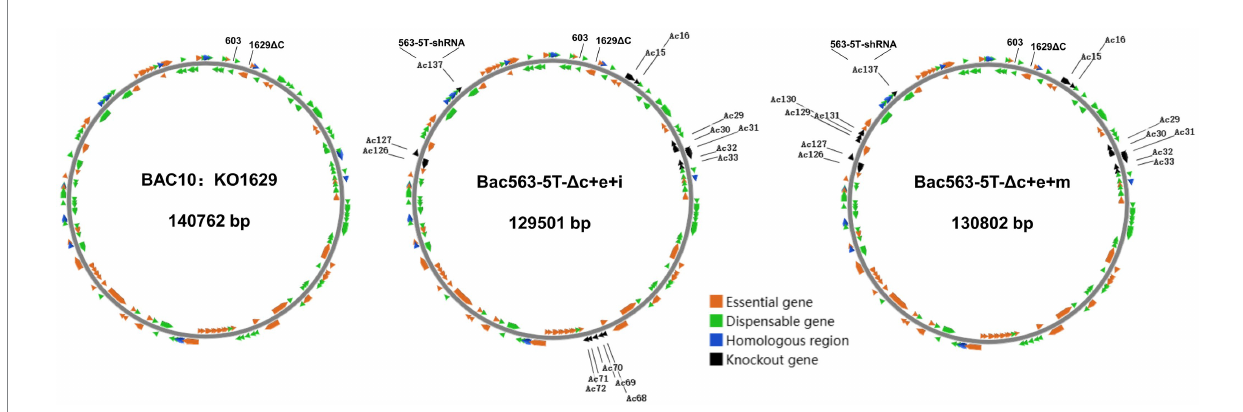
FIGURE 7 Schematic diagram of AcMNPV bacmid BAC10:KO1629 and the two shortened bacmids with improved capacity for recombinant protein production. BAC10:KO1629 (left) is 140,762 bp, containing 154 AcMNPV ORFs and a F replicon (Kan r ) fragment inserted between ORF603 and truncated ORF1629. Compared with BAC10:KO1629, the shortened Bac563-5 T- Δ c + e + i containing deletions of Ac15-16 , Ac29-33 , Ac68-72 , Ac126-127 and Ac137 (middle) and Bac563-5 T- Δ c + e + m containing deletions of Ac15-16 , Ac29-33 , A c126-127 , Ac129-131 and Ac137 (right) exhibit similar replication ability and better protein